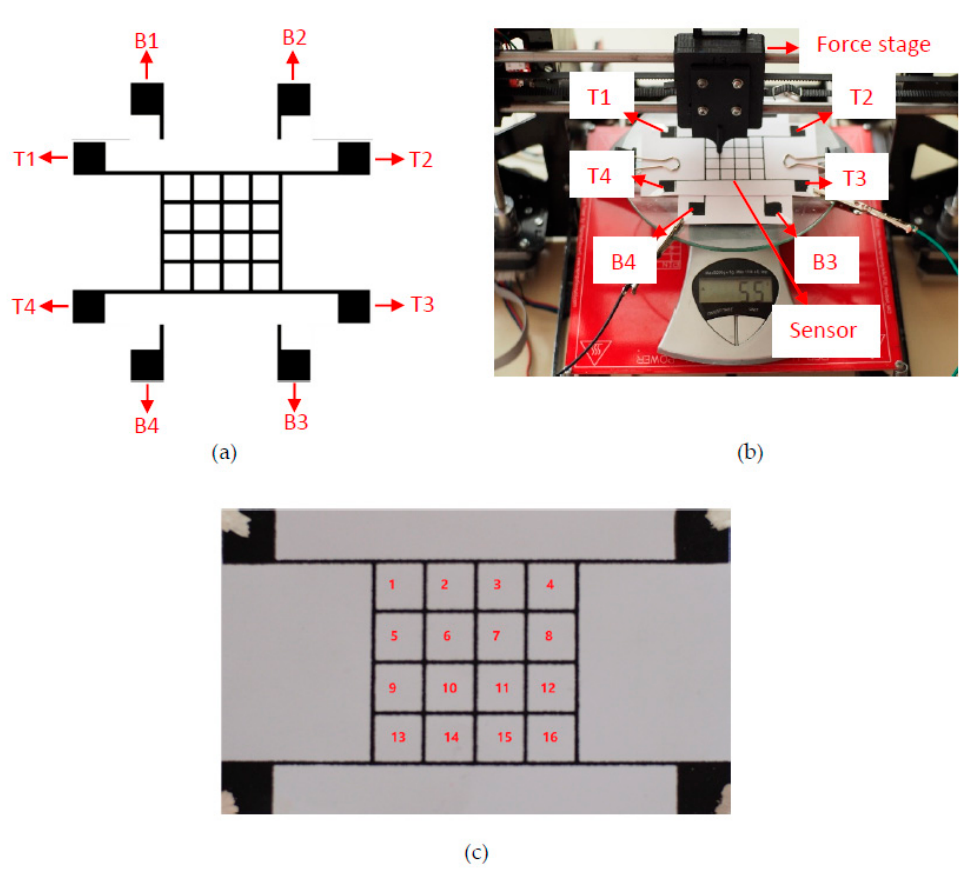
Figure 4. ( a ) Illustration of measurement pads of the tactile sensor. ( b ) Automated measurement setup capable of applying force and pressure at high precision. ( c ) The picture of a fabricated sensor array with numbers given to point the locations on the topmost sensor array.